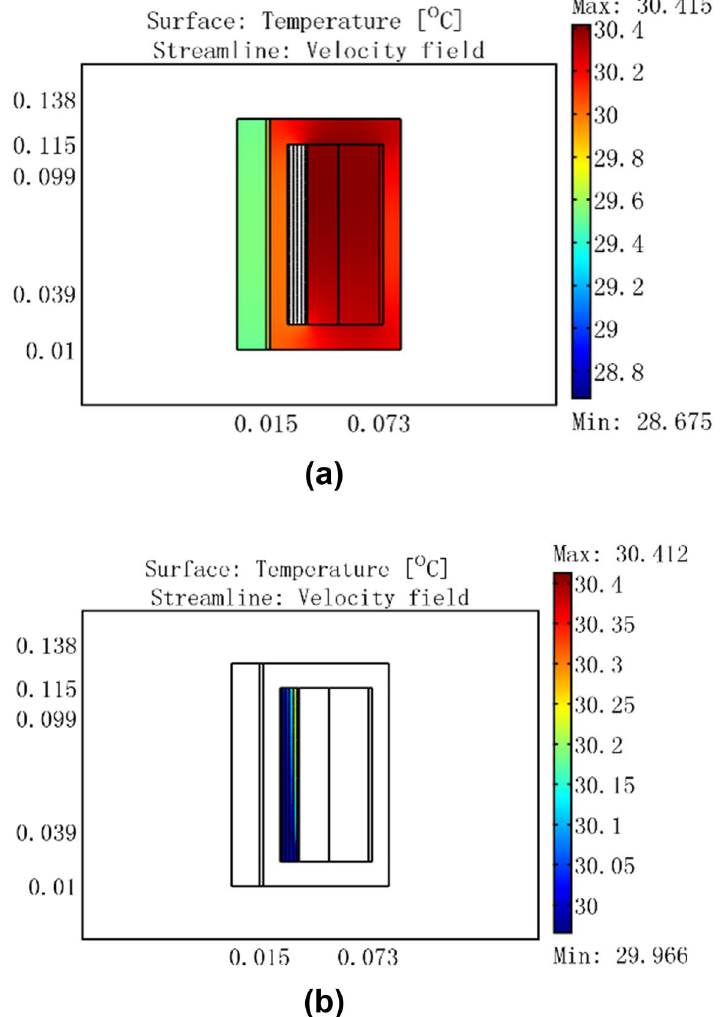
Figure 10. GMM smart component temperature distribution for a current of 3 A, cooling water temperature of 30 °C, and flow rate of 0.01